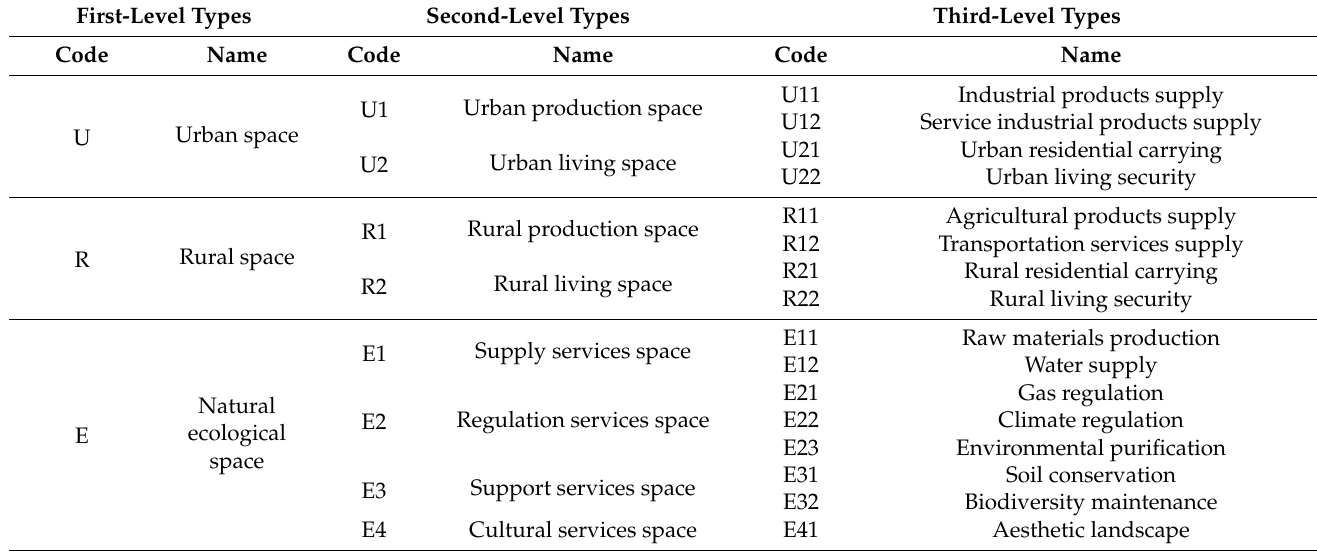
Table 2. Theoretical framework of